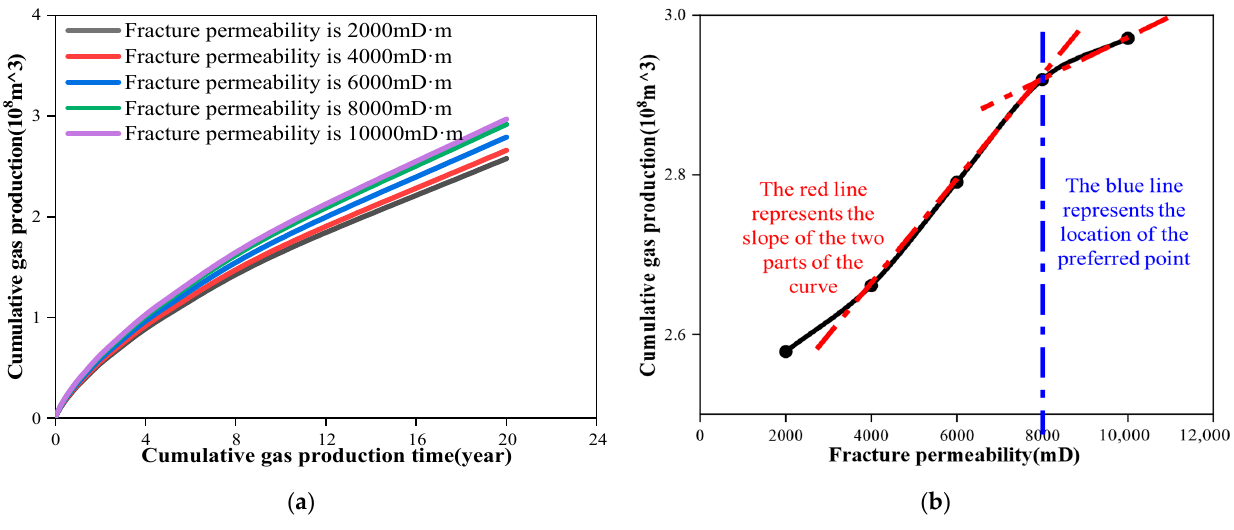
Figure 15. ( a ) Comparison of cumulative production under different fracture permeabilities and ( b ) schematic diagram of fracture permeability optimization.